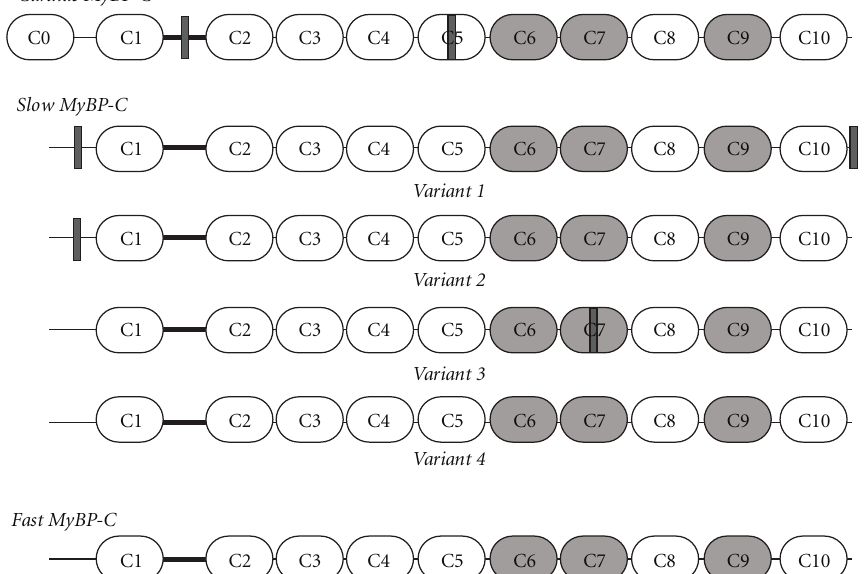
Figure 1: Schematic representation of the three MyBP-C isoforms. White and light grey ovals represent immunoglobulin and fibronectin type-III domains, respectively. The M-motif, flanked by domains C1 and C2 is denoted as a thick black line. Insertions specific to the cardiac isoform and slow variants are shown as dark grey